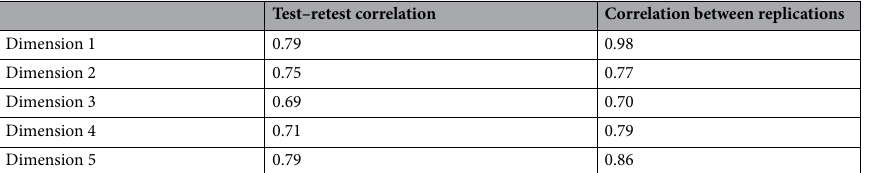
Table 2. Reproducibility and reliability analysis. Test–retest correlation represents the test–retest reliability within participants. The correlation between replications captures the reproducibility of our dimensional structure across